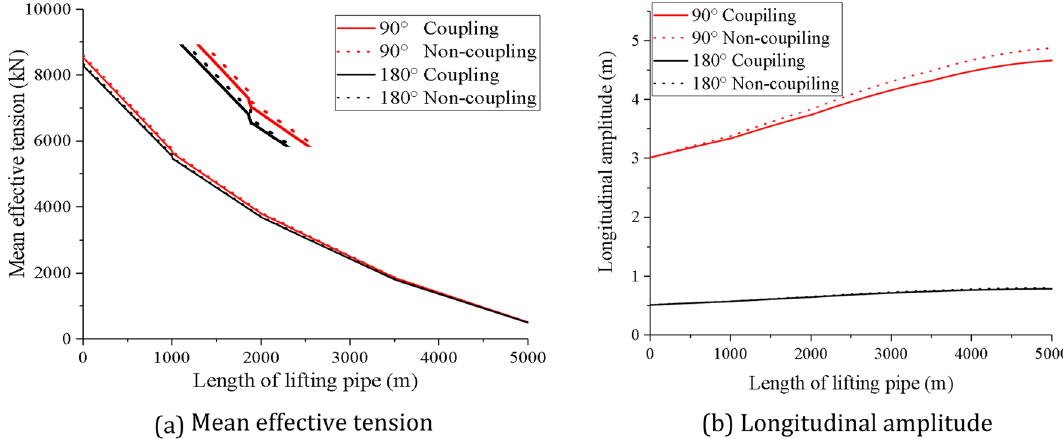
Figure 17. Dynamic response of lifting pipe along pipe length under different wave directions (created by Origin 2017 software, URL: https:// www. origi nlab.